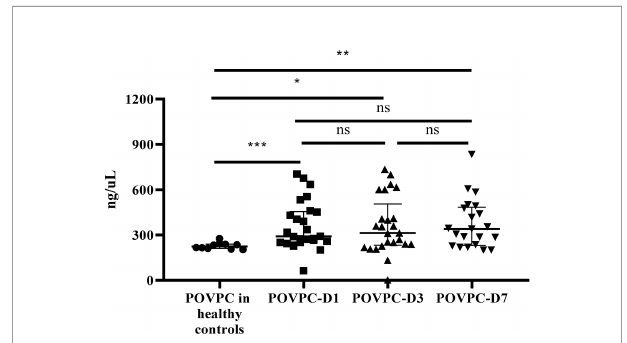
FIGURE 2 | The persistent increase of HDL POVPC in septic patients vs. healthy controls. The difference in HDL POVPC between healthy controls and septic patients, and the increased levels were persistent in the course of sepsis. Data were presented in median with interquartile range. N=10 for healthy controls, n=14 for survivors, n=11 for non-survivors (D1 and D3), n=7 for non-survivors (D7); POVPC, 1-palmitoyl-2- (5-oxovaleroyl) -sn-glycero- phosphatidylcholine; D1, Day 1; D3, Day 3; D7, Day 7. *p<0.05; **p<0.01; ***p<0.001; ns, not signi fi cant.